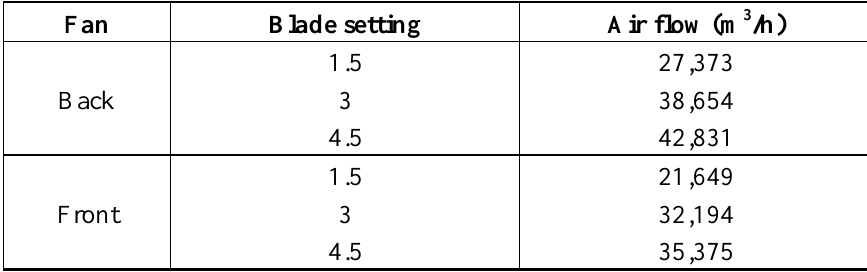
Table 1. Air flows of the back and front fans of the